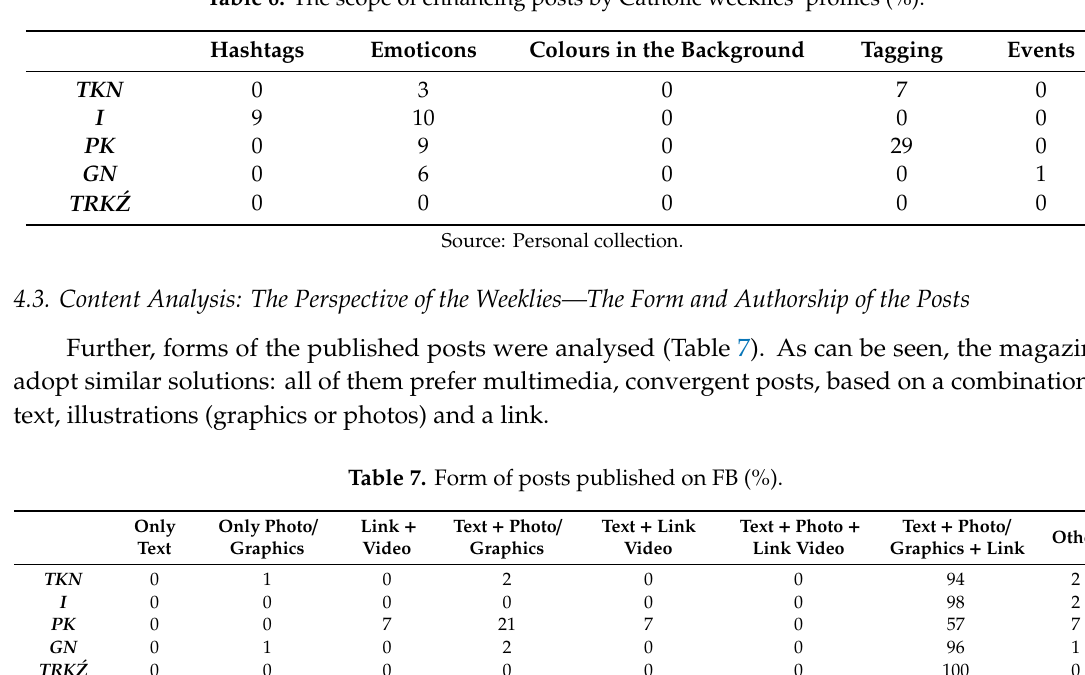
Table 6. The scope of enhancing posts by Catholic weeklies’ profiles (%).